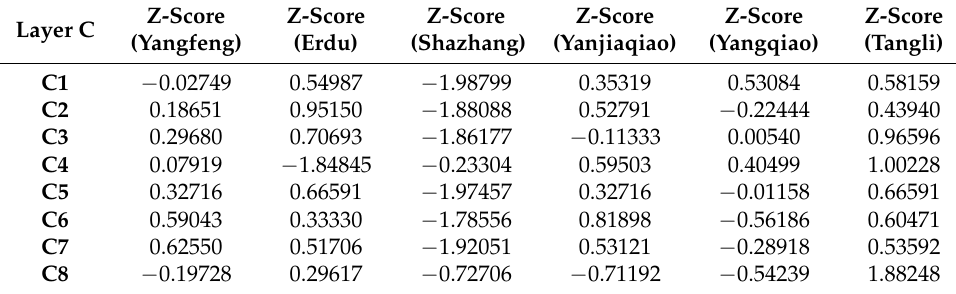
Table 7. Normalized results of Z-scores for sub-indicators at layer